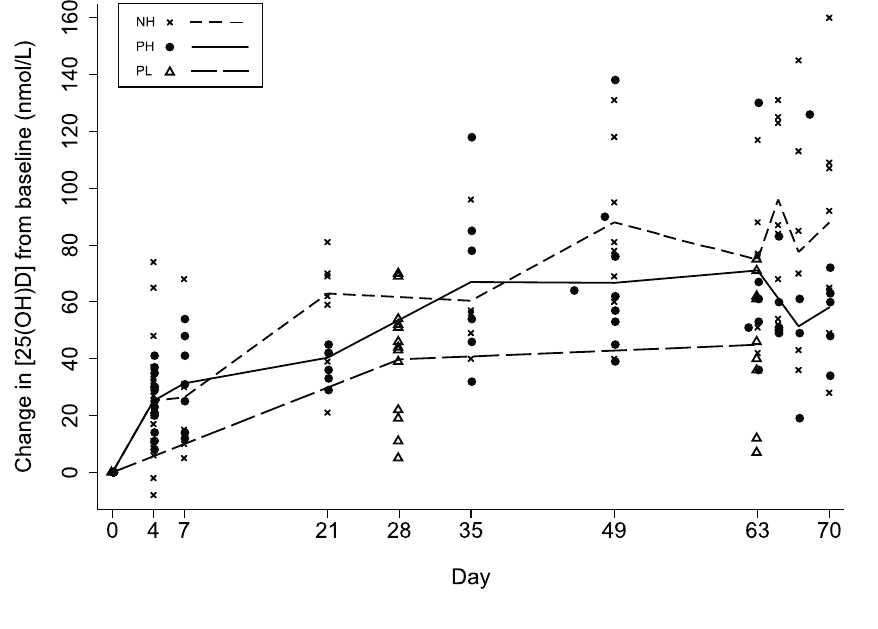
Figure 4. Lack of inter-dose fluctuations in mean serum 25-hydroxyvitamin D concentrations among non-pregnant (NH) and pregnant women (PH) during the 10th week of supplementation with 35,000 IU vitamin D3 per week, with the most recent dose administered on day 63. Lines connect the group means at each day; 95% confidence intervals are represented by vertical capped